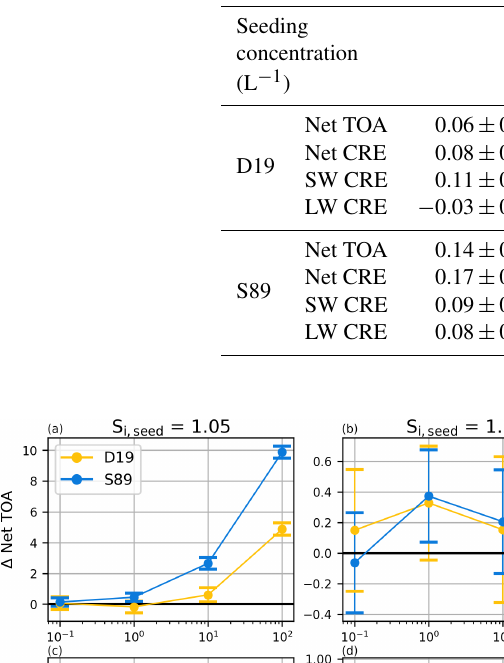
Table 4. Five-year annual global mean net top-of-atmosphere total radiative balance (TOA) and net CRE as well as SW CRE and LW CRE in Wm − 2 for the D19 and S89 ice cloud fraction approaches for seeding with S i,seed = 1.05. Each quantity includes the 95% confidence interval equating to 2 standard deviations of the mean values of the 5-year data.